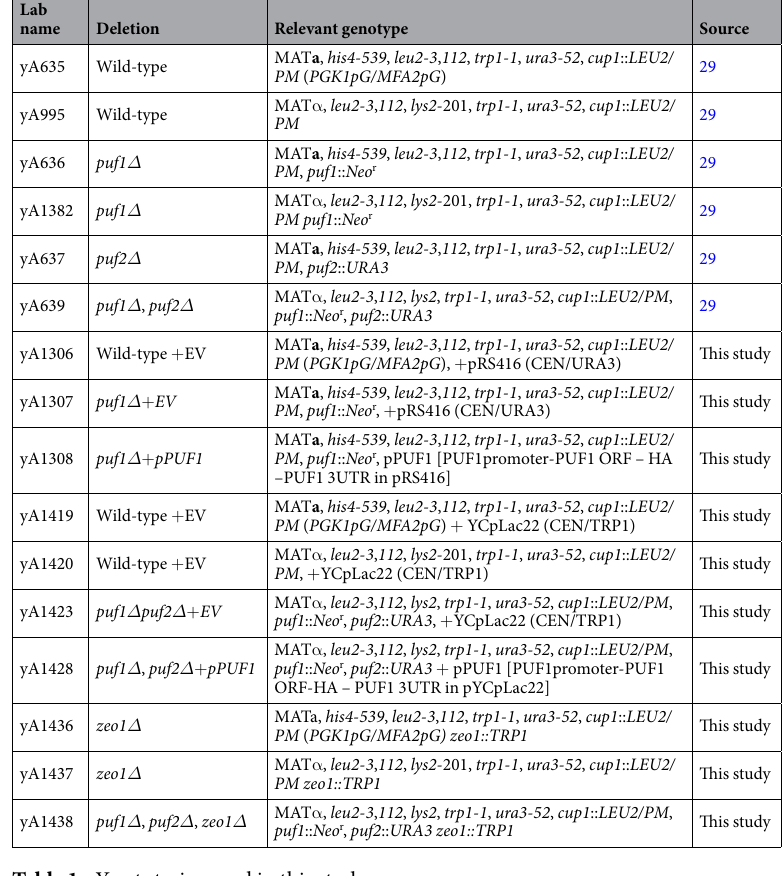
Table 1. Yeast strains used in this